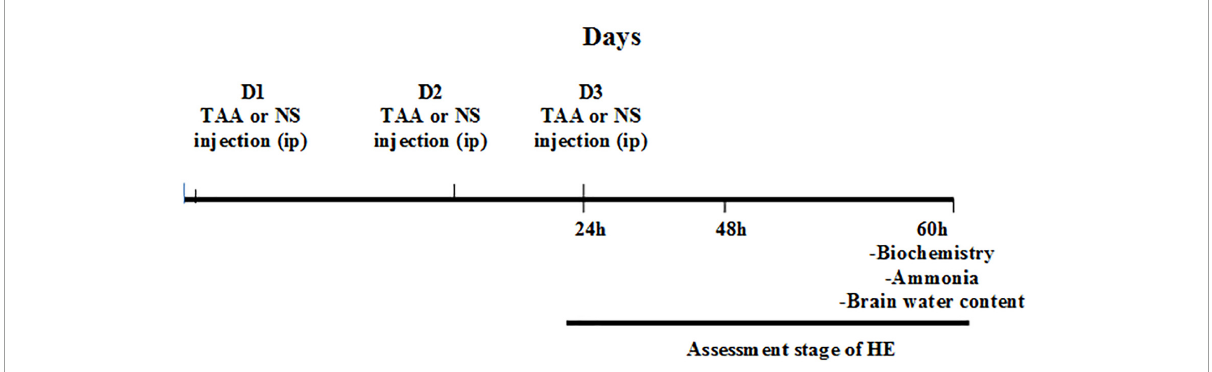
FIGURE1 Experimental procedure. D1, the first day for thioacetamide (TAA) or normal saline (NS) injection; D2, the second day for TAA or NS injection; D3, the third day for TAA or NS injection 24 h: 24 h after the second TAA or NS injection, 48 h: 48 h after the second TAA or NS injection, and 60 h: 60 h after the second TAA or NS